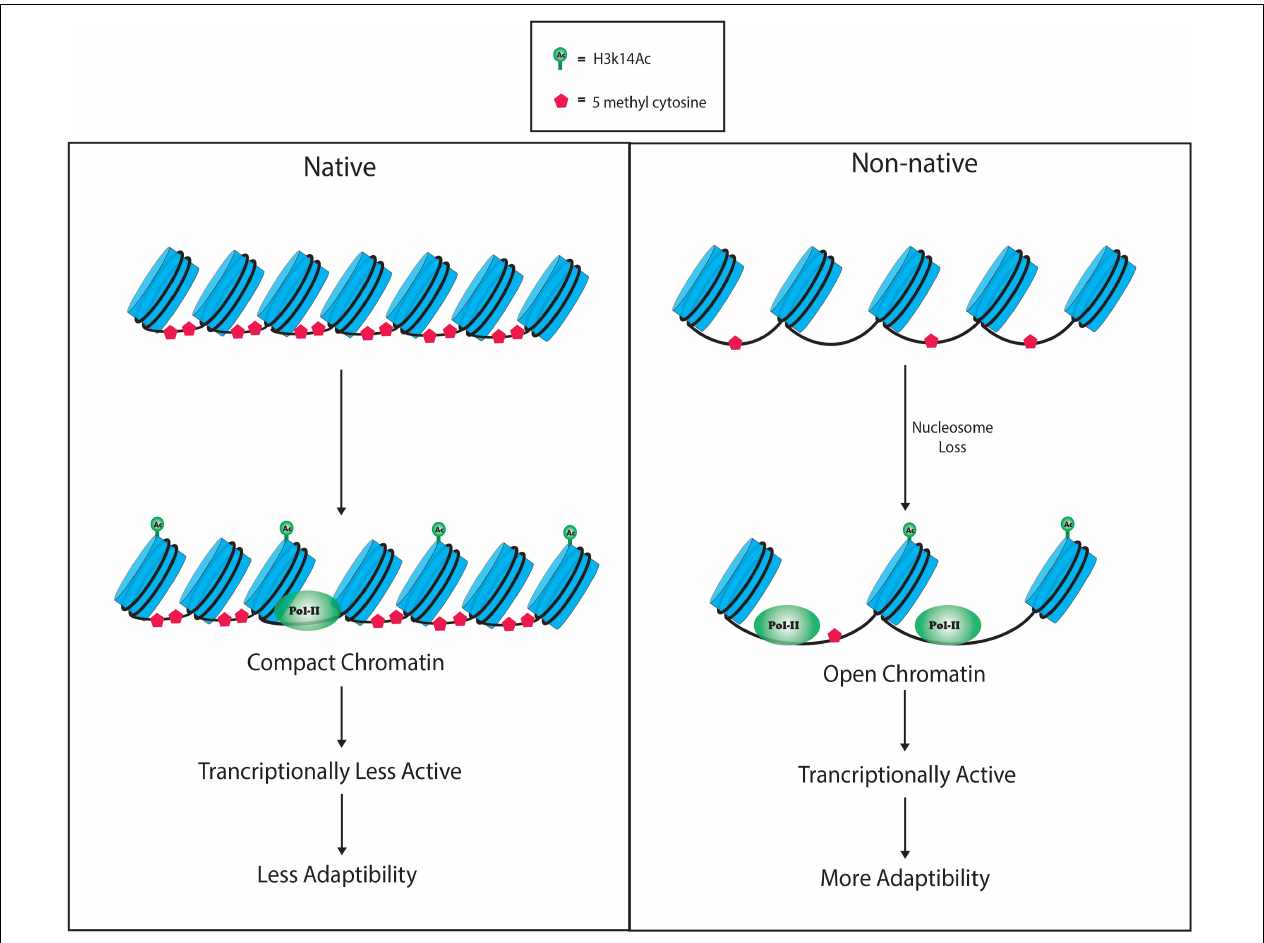
FIGURE 5 | Model showing changes in chromatin organization in the native (North America) and non-native (Kashmir Himalaya) samples of C. canadensis . The model represents the compact and open chromatin at ABC transporter genes in the native and non-native range plants of C. canadensis. The non-native range plants showed open chromatin possibly due to decreased DNA methylation and increased H3K14ac occupancy at the ABC transporter gene and hence making the ABC transporter gene transcriptionally more active in the non-native ones as compared with native range plants of C.